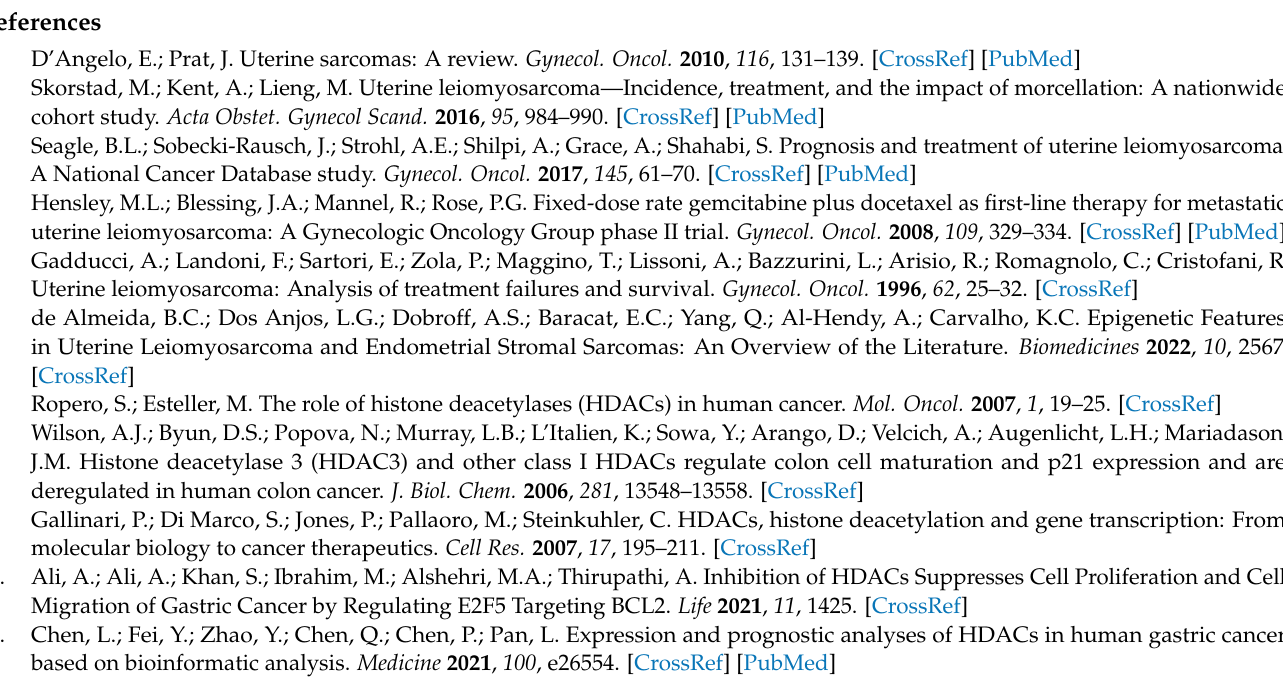
Table S2: DL-sulforaphane drug similarity analysis; Table S3: Candidate drugs that target the top 10 percent of EMT modules’ genes; Table S4: Drug candidates for EMT